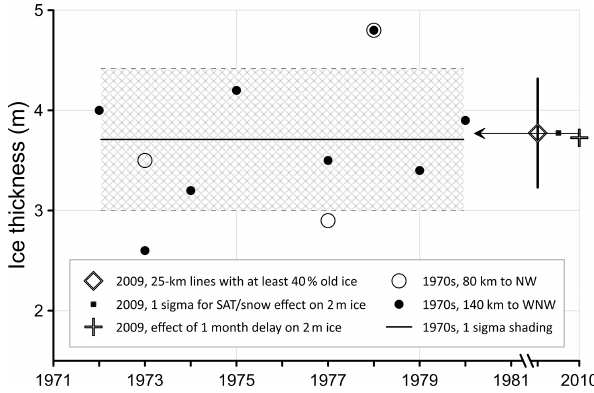
Figure 12. Track-mean ice thickness of multi-year ice from drill- hole surveys northwest of the Penny Strait during late winter in the 1970s, compared with 2010 winter values derived from observa- tions in the autumn of 2009, as explained in the text.